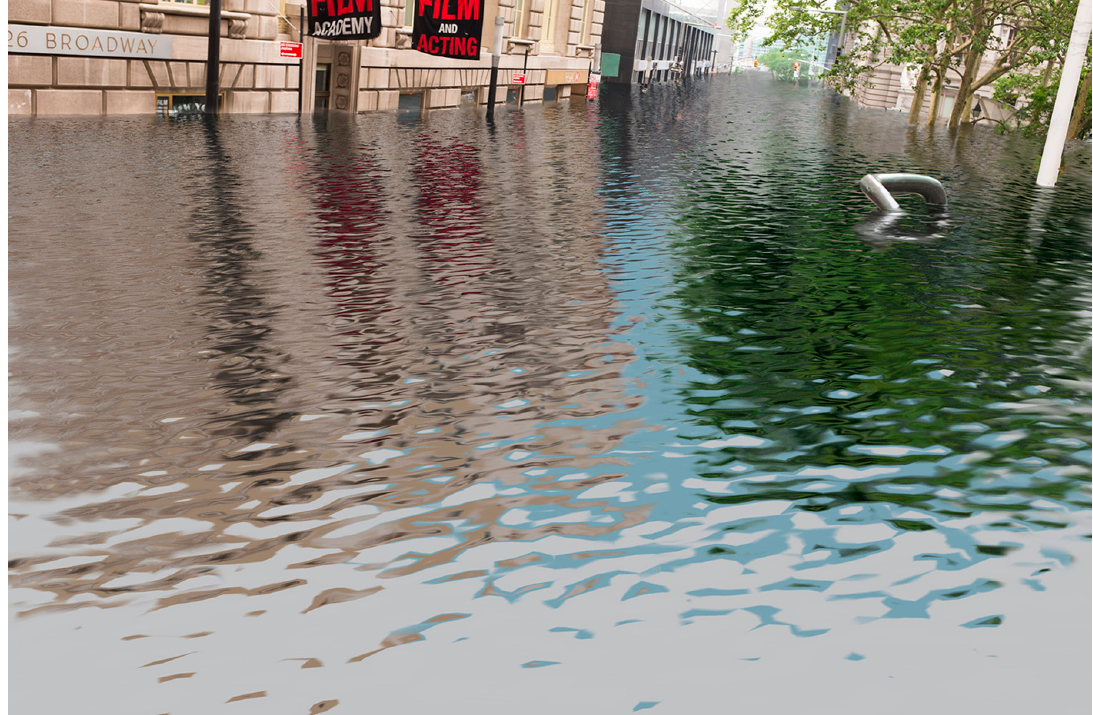
Figure 3. Climate Central’s image of New York City at 4 °C of warming.